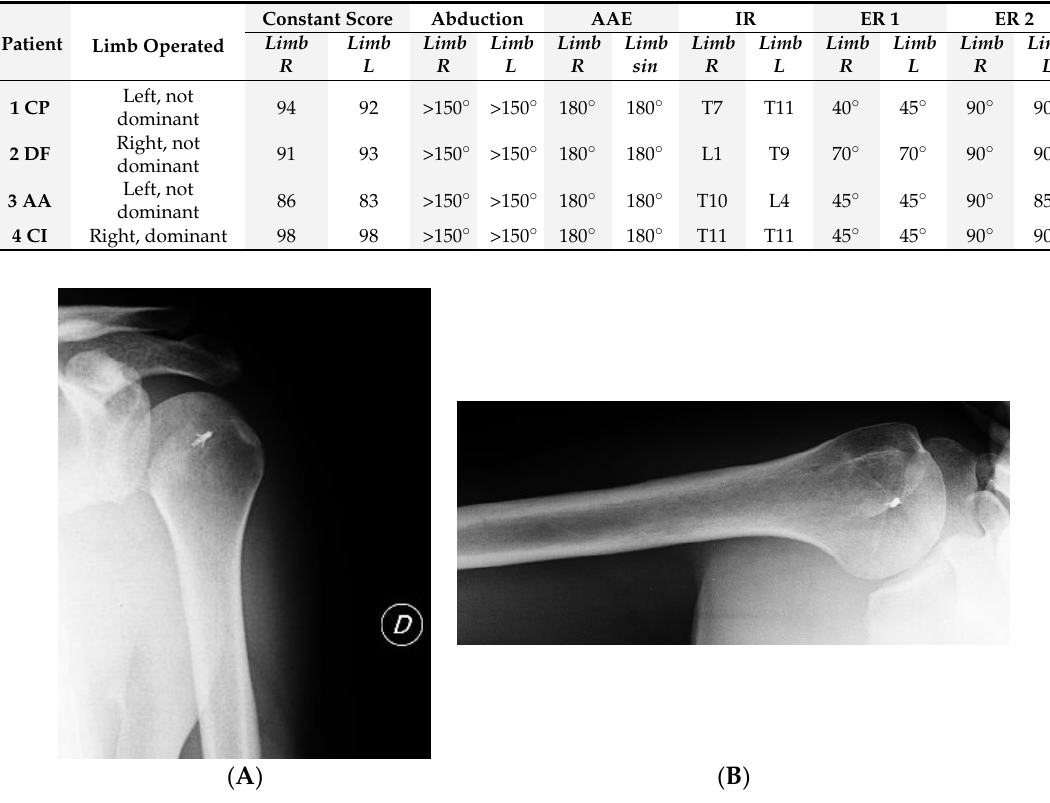
Figure 4. ( A , B ) Patient 4 post-surgery RX–AP and axial scans.